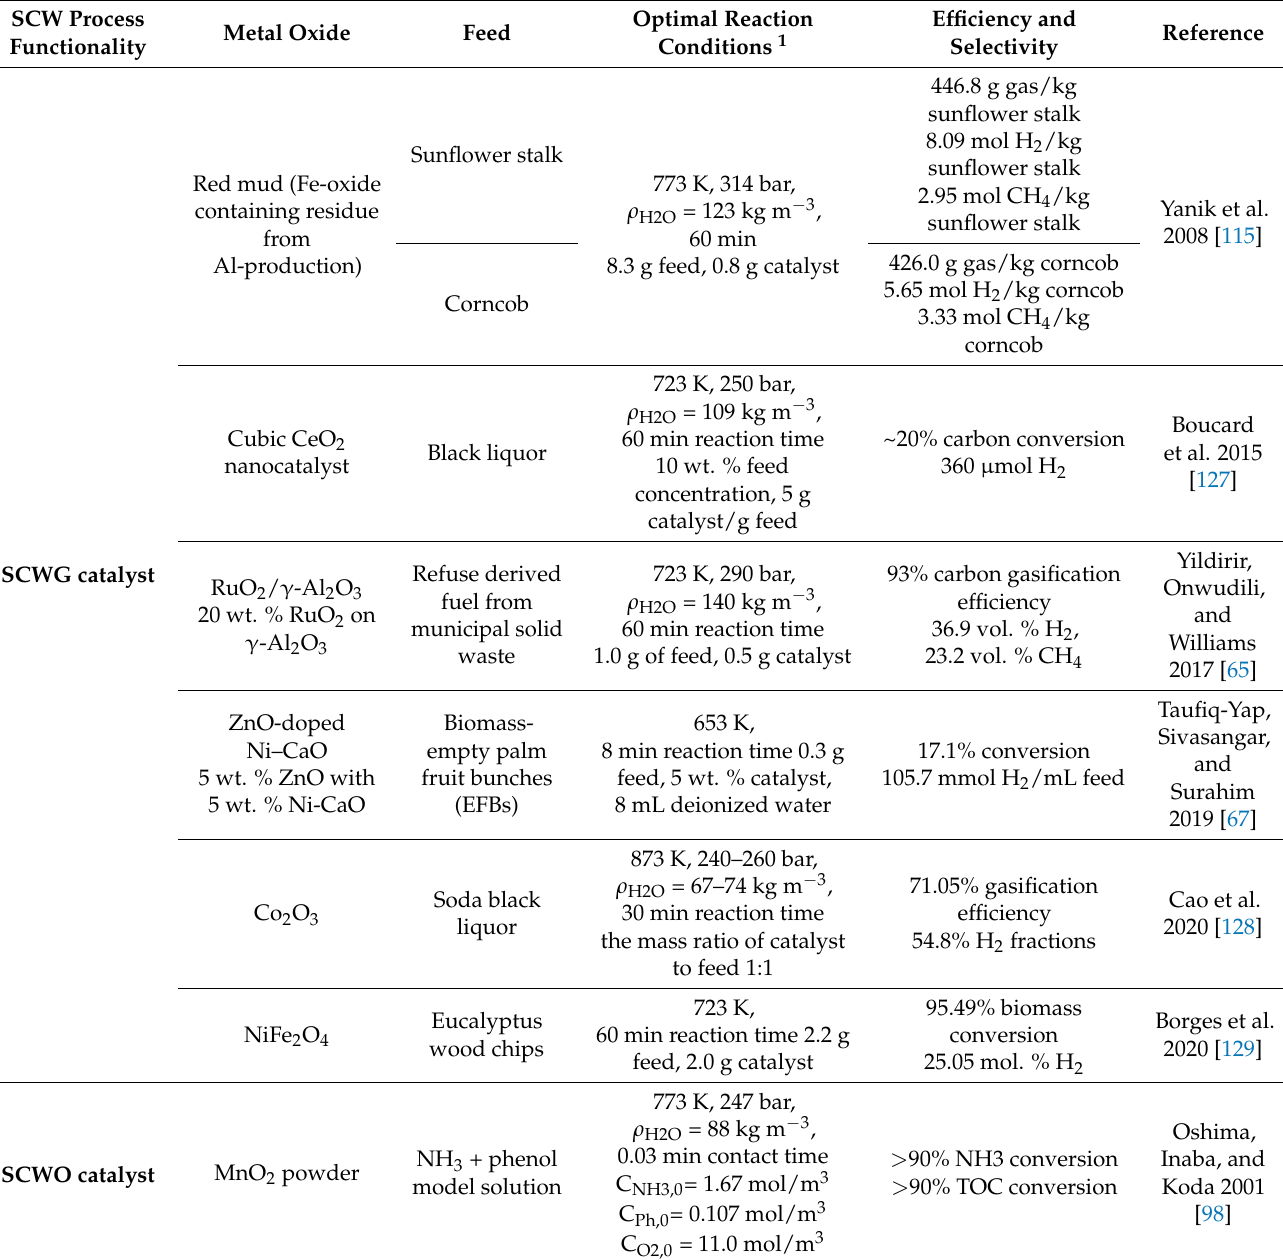
Table 2. Metal oxide materials for SCW